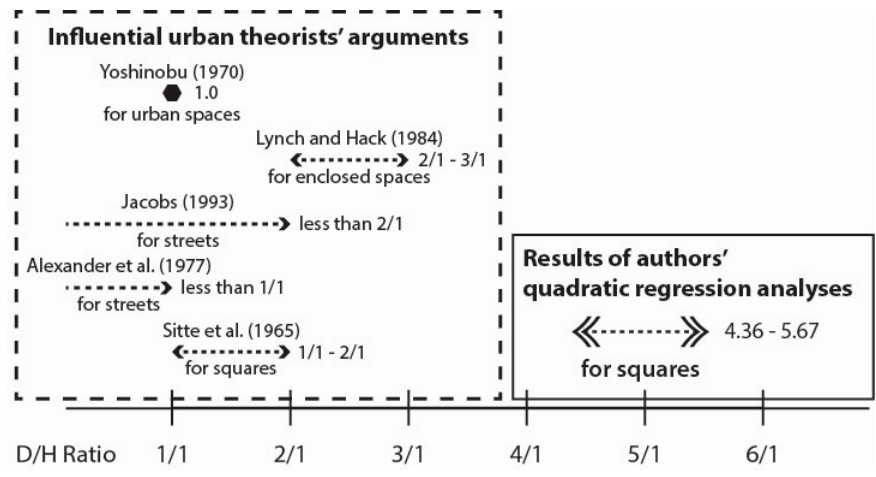
Figure 5. Comparison of optimal D/H ratios: theorists’ arguments and results of authors’ quadratic regression analyses.